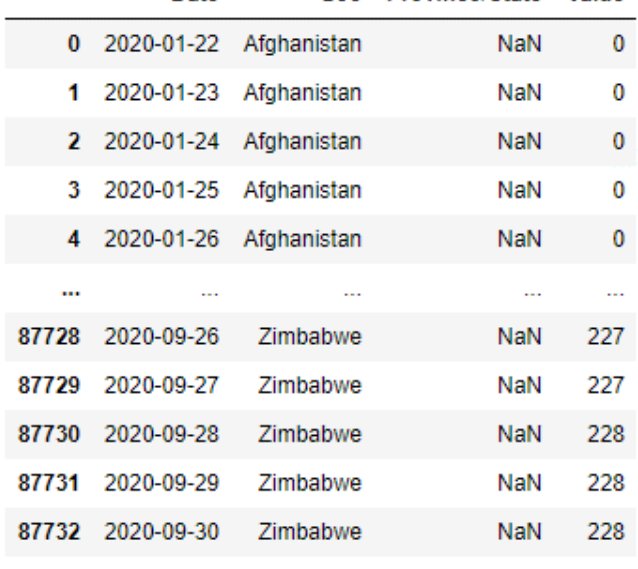
Figure 8. Johns Hopkins University Centre’s dataset of COVID-19 deaths